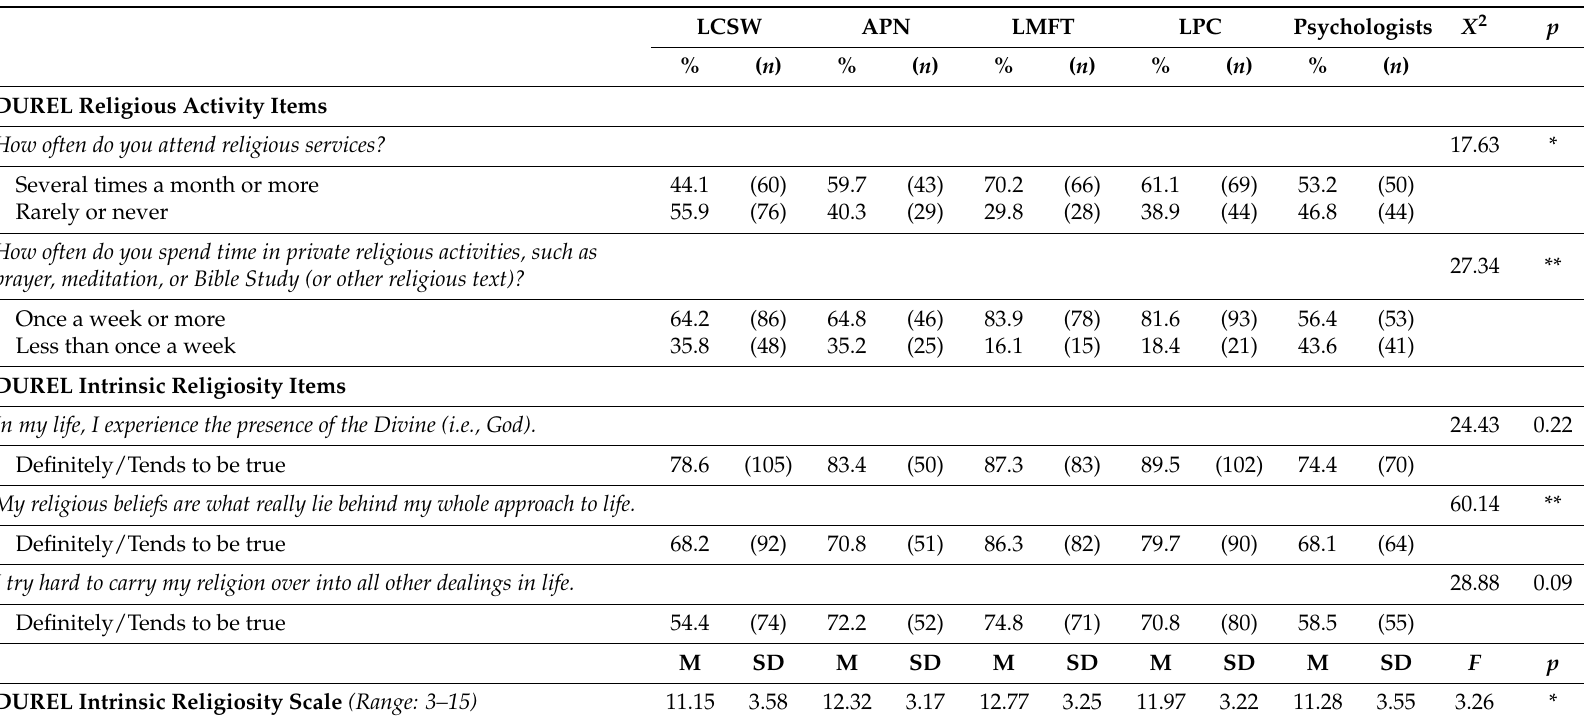
Table 2. Intrinsic and Extrinsic Religiosity among Helping Professions in